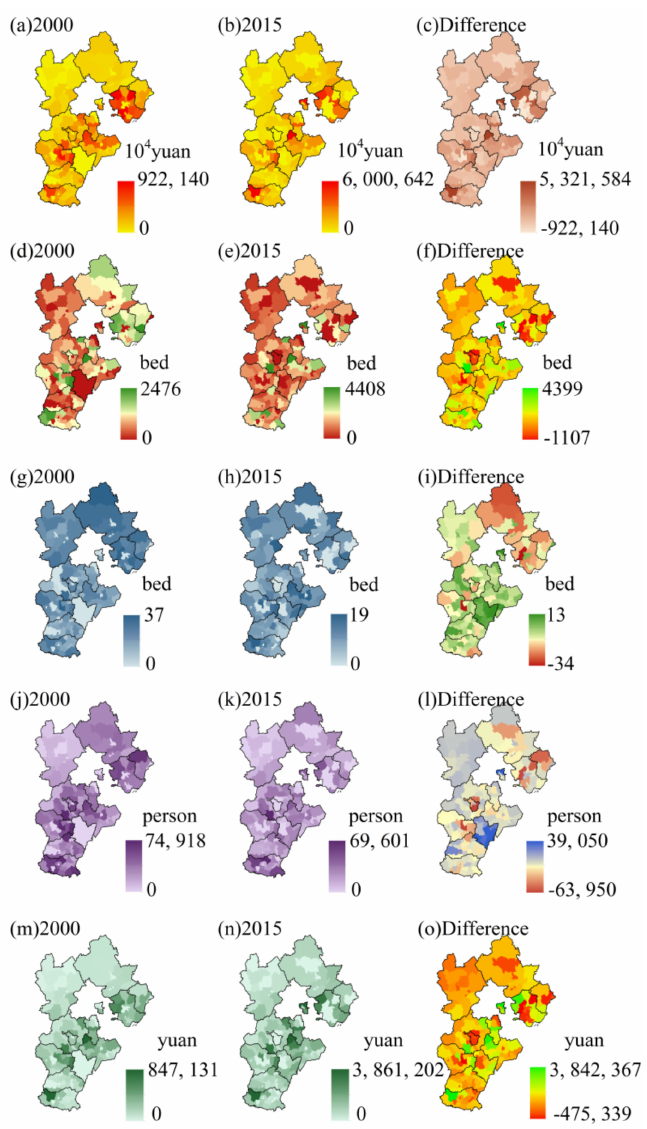
Figure 5. Spatiotemporal distribution of HWB in Hebei from 2000–2015: ( a – c ) basic material needs of maintaining a high-quality life; ( d – f ) health; ( g – i ) safety; ( j – l ) good relationship; and ( m – o ) the freedom of choice and